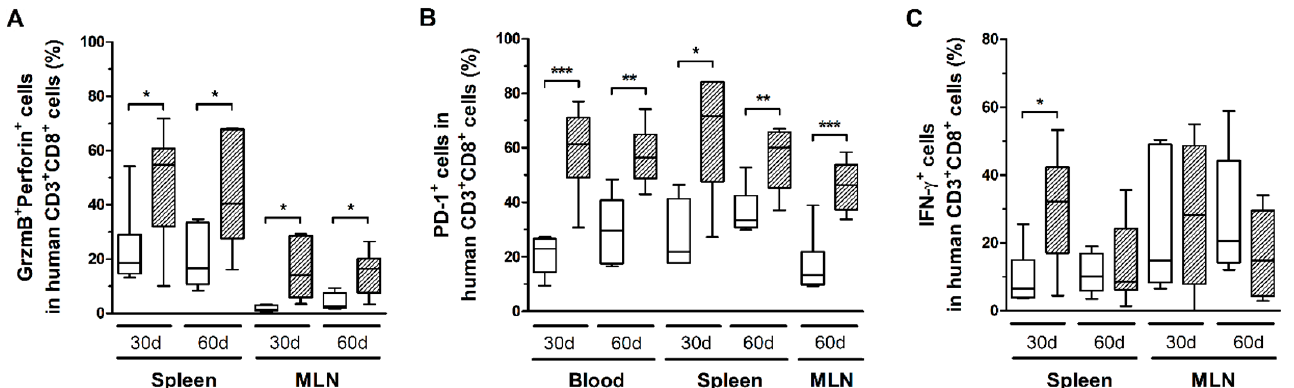
Figure 6. Granzyme B, perforin, IFN- γ , and PD-1 expression in CD8 + T-cells. Blood, spleen, and mesenteric lymph nodes (MLN) from control (white box) and HTLV-1-infected HIS-NSG mice (dashed box) were collected at 30 days and 60 days from inoculation. The frequency of CD8 + T-cells expressing ( A ) Granzyme B (GrzmB) and perforin, ( B ) PD-1, and ( C ) IFN- γ was determined by flow cytometry. The surface expression of PD-1 was detected in non-stimulated cells, while GrzmB, perforin, and IFN- γ were intracellularly stained after 6 h of stimulation with phorbol-myristate-acetate and ionomycin. Frequency is shown within CD8 + T-cells. Statistical analysis was performed with Student’s t -test (*, p < 0.05; **, p < 0.01; ***, p < 0.001). Control groups 30 d and 60 d: n = 7; HTLV-1-infected group 30 d: n = 8; HTLV-1-infected group 60 d: n = 6.